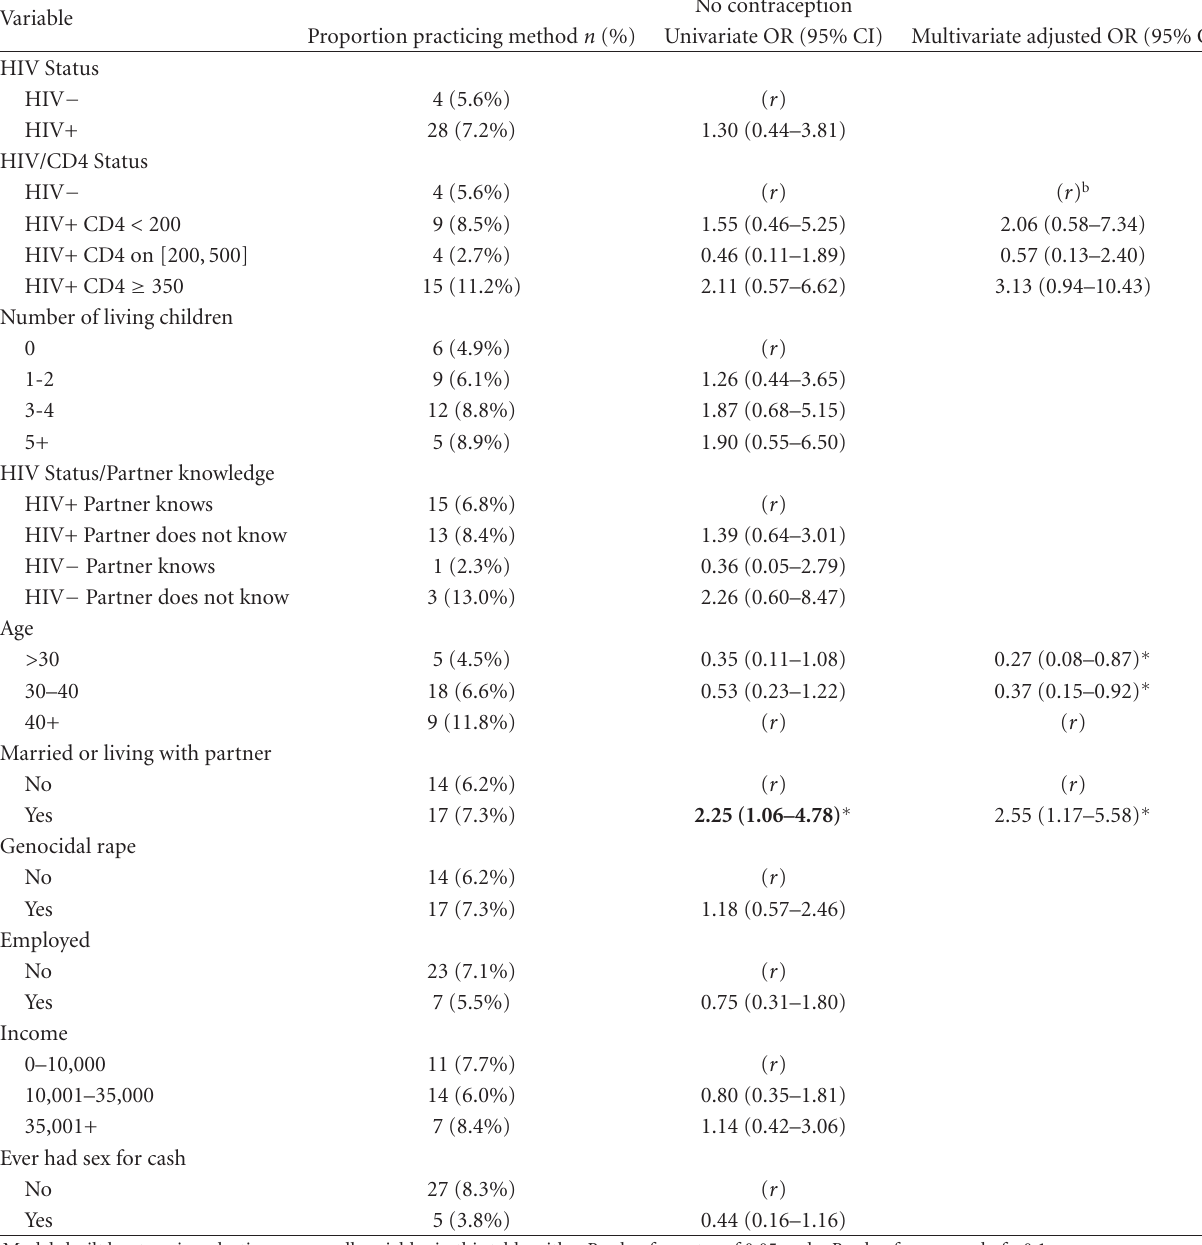
Table 5: Univariate and multivariate analysis of demographic and clinical characteristics of nonuse of contraception 1